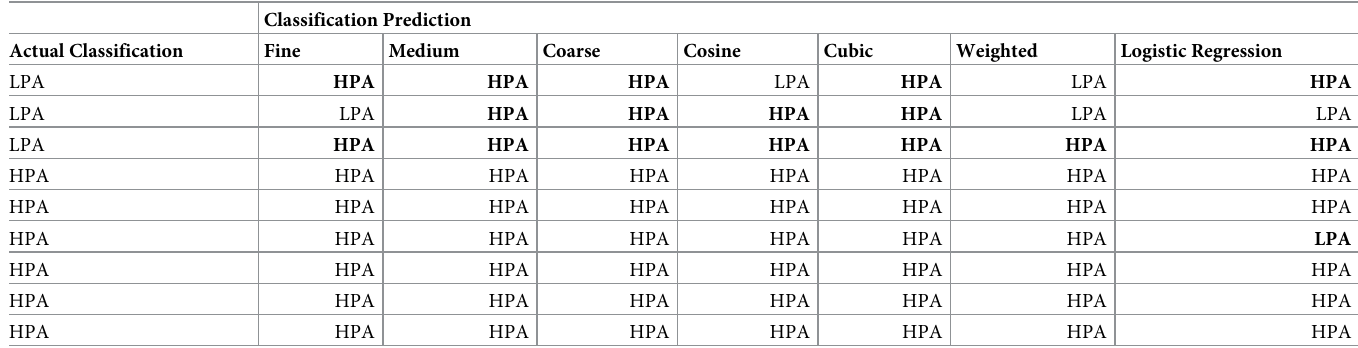
Table 4. Classification efficacy of the developed models against fresh data. Classification